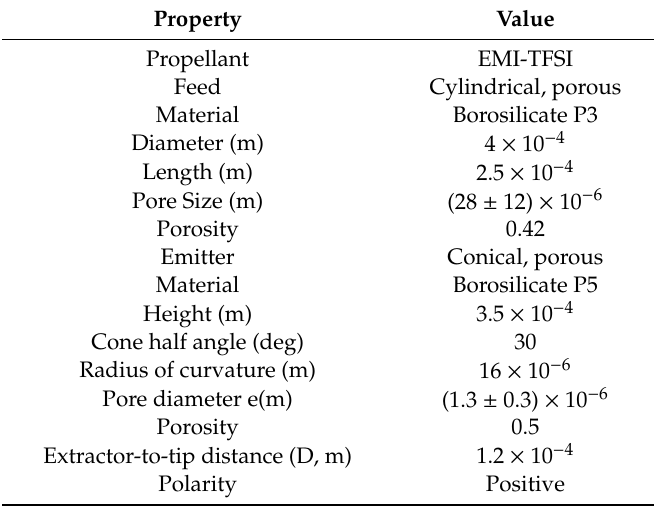
Figure 21. Conical porous borosilicate glass emitter used to benchmark ESPET. Table 11. Properties of the conical borosilicate emitter and feed